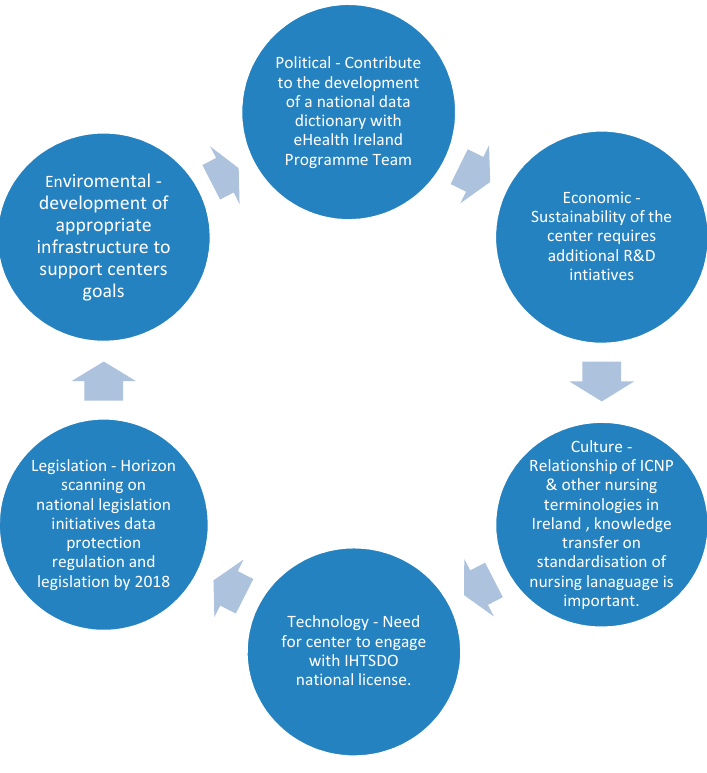
Figure 2. Summary of Actions Planned from PESTLE Analysis Tool Exercise.